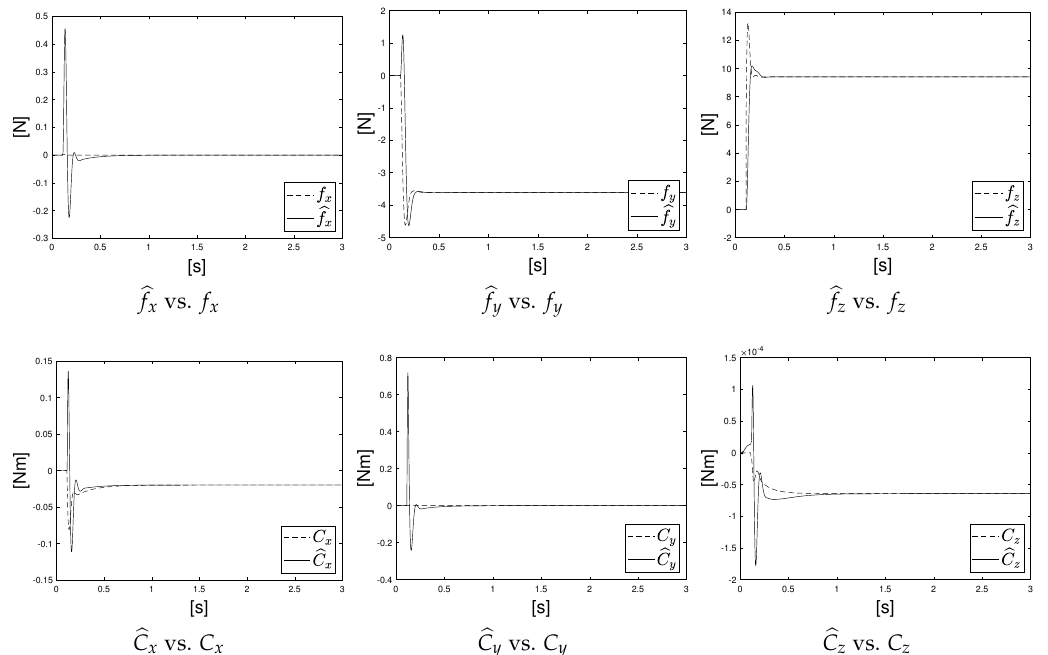
Figure 5. Estimated interaction forces (cid:98) f and torques (cid:98) C (continuous line) vs. real interaction forces f and torques C (dashed line) for the #3 simulation scenario.